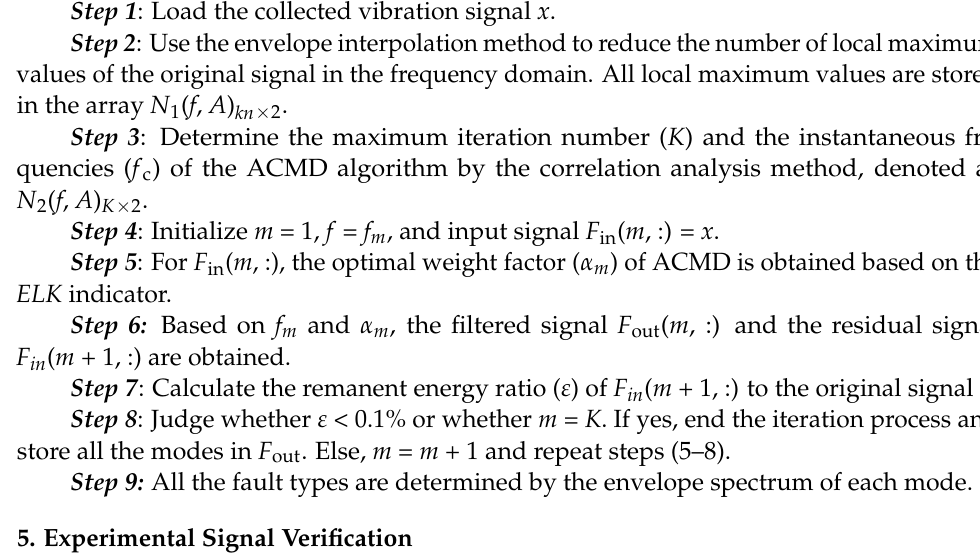
Figure 12. Fault diagnosis steps based on the proposed IMACMD method.